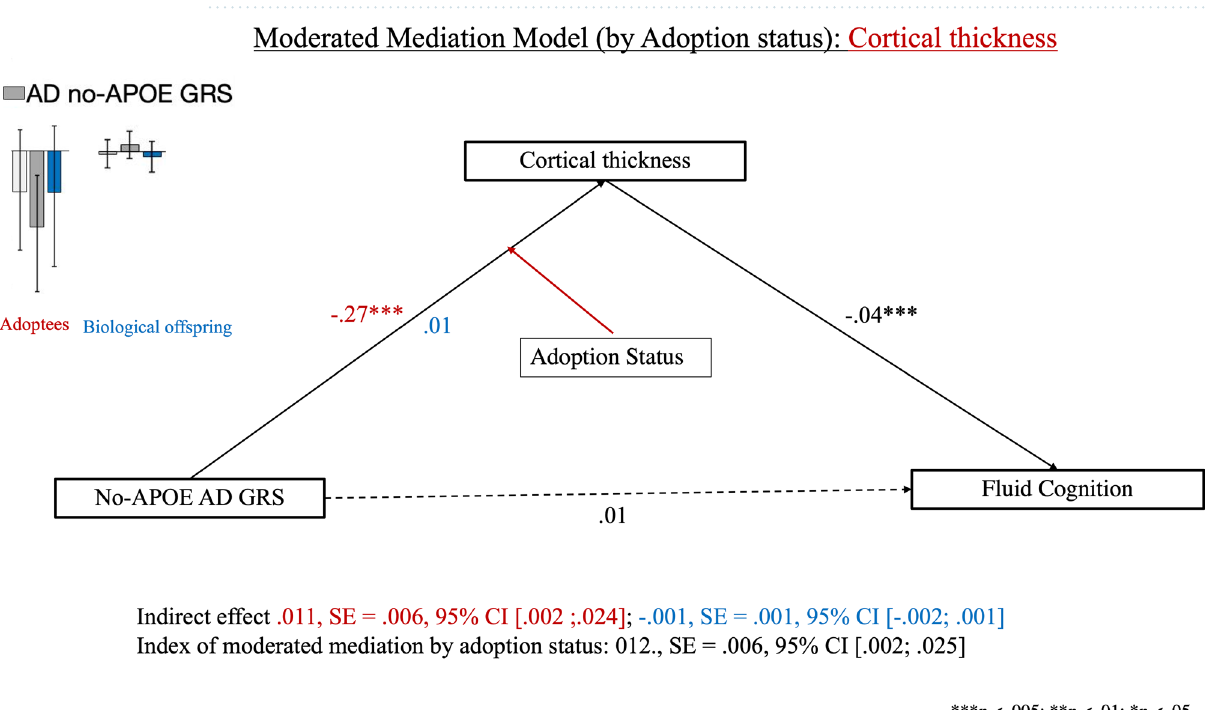
Figure 4. Results of the moderated mediation analysis comparing the effect of the no-APOE AD GRS on fluid cognition via cortical thickness among adoptees and non-adoptees. AD Alzheimer’s Disease, APOE Apolipoprotein E, GRS genetic risk score. Coefficients in red font describe the adoptees, those in blue font, the biological offspring, whereas those in black font apply to the full